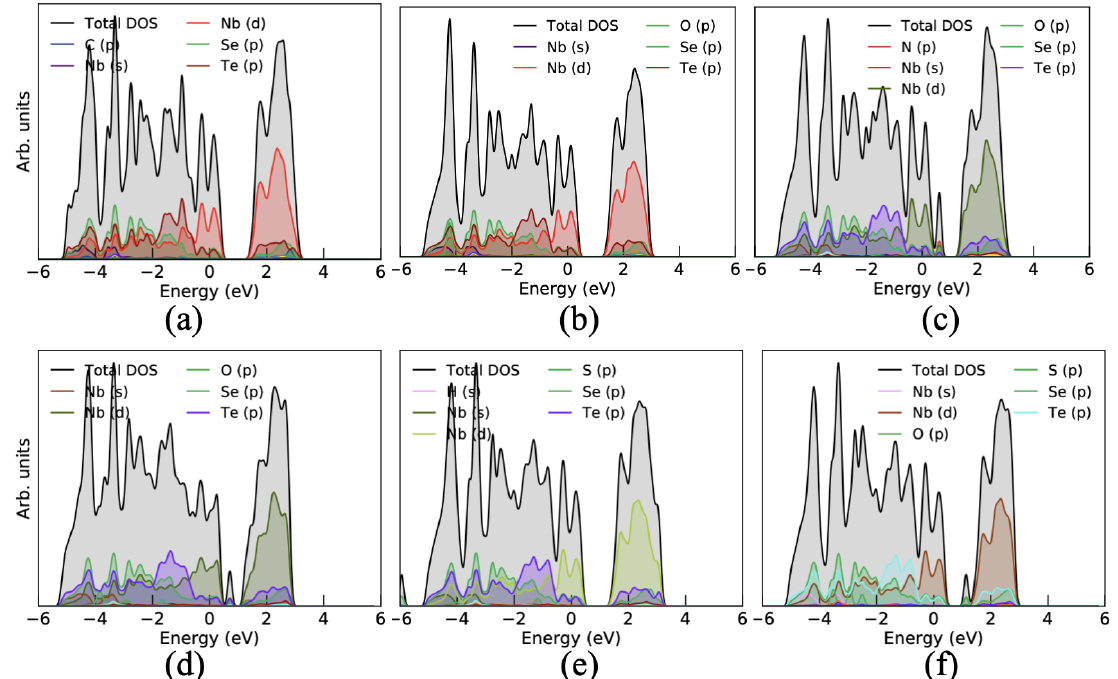
Figure 5. Projected density of states (PDOS) influenced by the toxic gas molecules adsorbed on the surface of the Janus NbSeTe monolayer with top and side view. ( a ) CO, ( b ) CO 2 , ( c ) NO, ( d ) NO 2 , ( e ) H 2 S, and ( f ) SO 2 gas molecules adsorbed on the Te-side of the Janus NbSeTe monolayer.